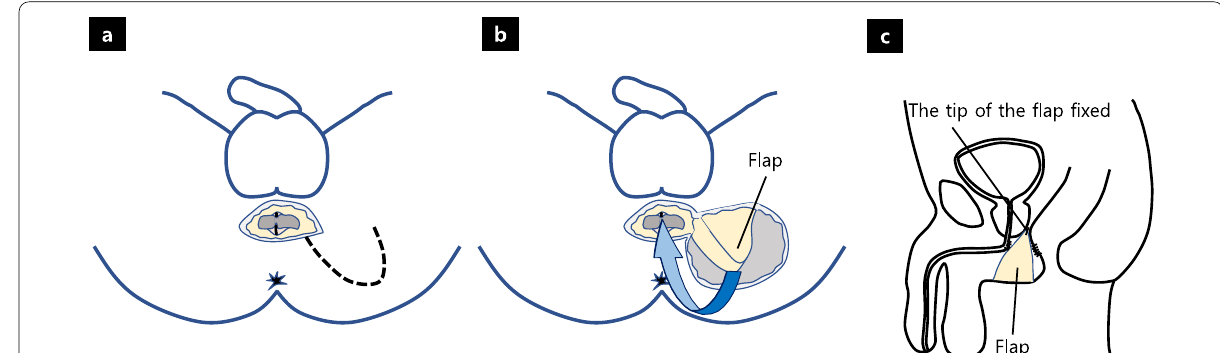
Fig. 5 Illustrations of the operative procedure. a Design of the gluteal local tissue flap. b Rotation and insertion of the flap. c Sagittal section